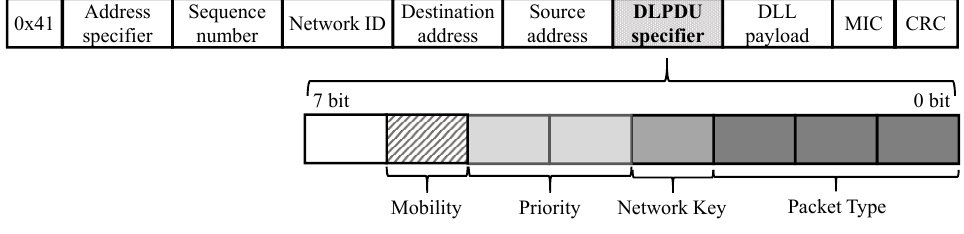
Figure 2. A modified data link protocol data unit